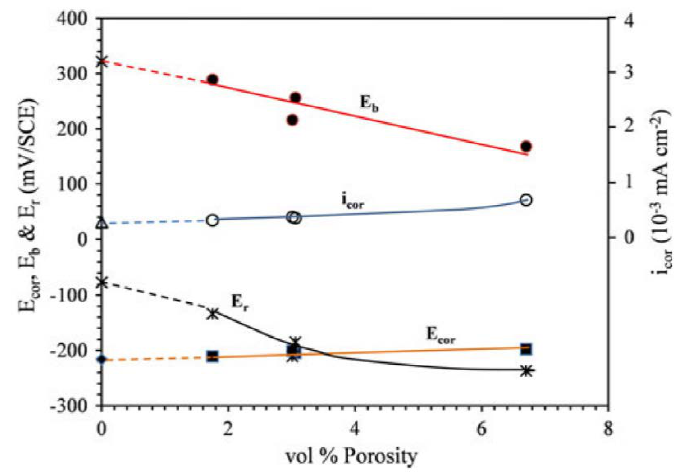
Figure 1. Corrosion potential (E cor ), breakdown potential (E b ), repassivation potential (E r ), and corrosion current density (i cor ) as a function of vol.% porosity in SLM samples [14].